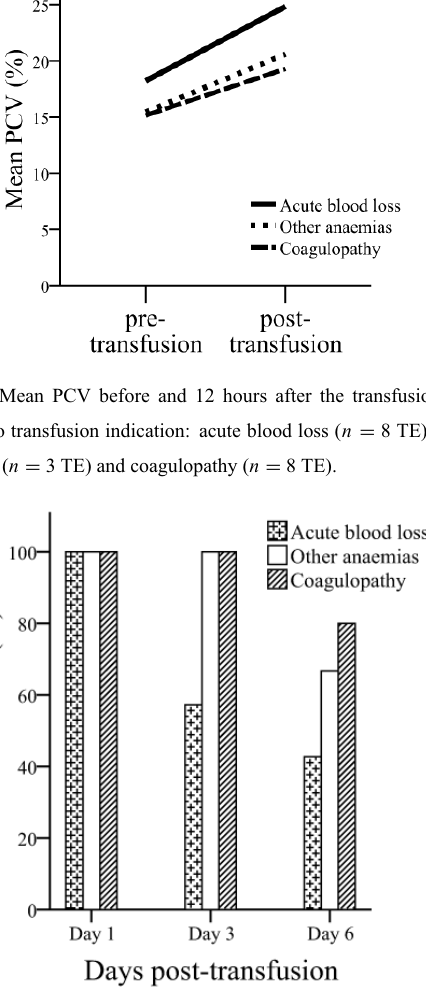
Fig. 2 – Survival rates at day 1, 3 and 6 post-transfusion on each etio- logic